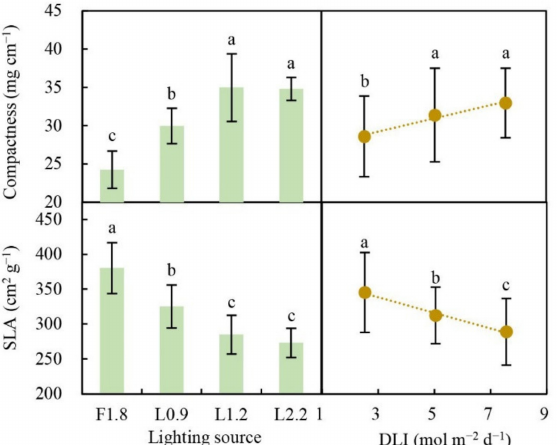
Figure 5. Effects of light quality during the whole seedling period and daily light integral (DLI) in the healing stage on compactness, specific leaf area (SLA) of grafted tomato transplants. There were no interactive effects of light quality and DLI on compactness ( P = 0.216) and SLA ( P = 0.716). Duncan’s test was used to make post-hoc multiple comparisons at α = 0.05 level ( n = 6). Vertical bars represent standard deviations. Different letters, a–c, indicate significant differences.